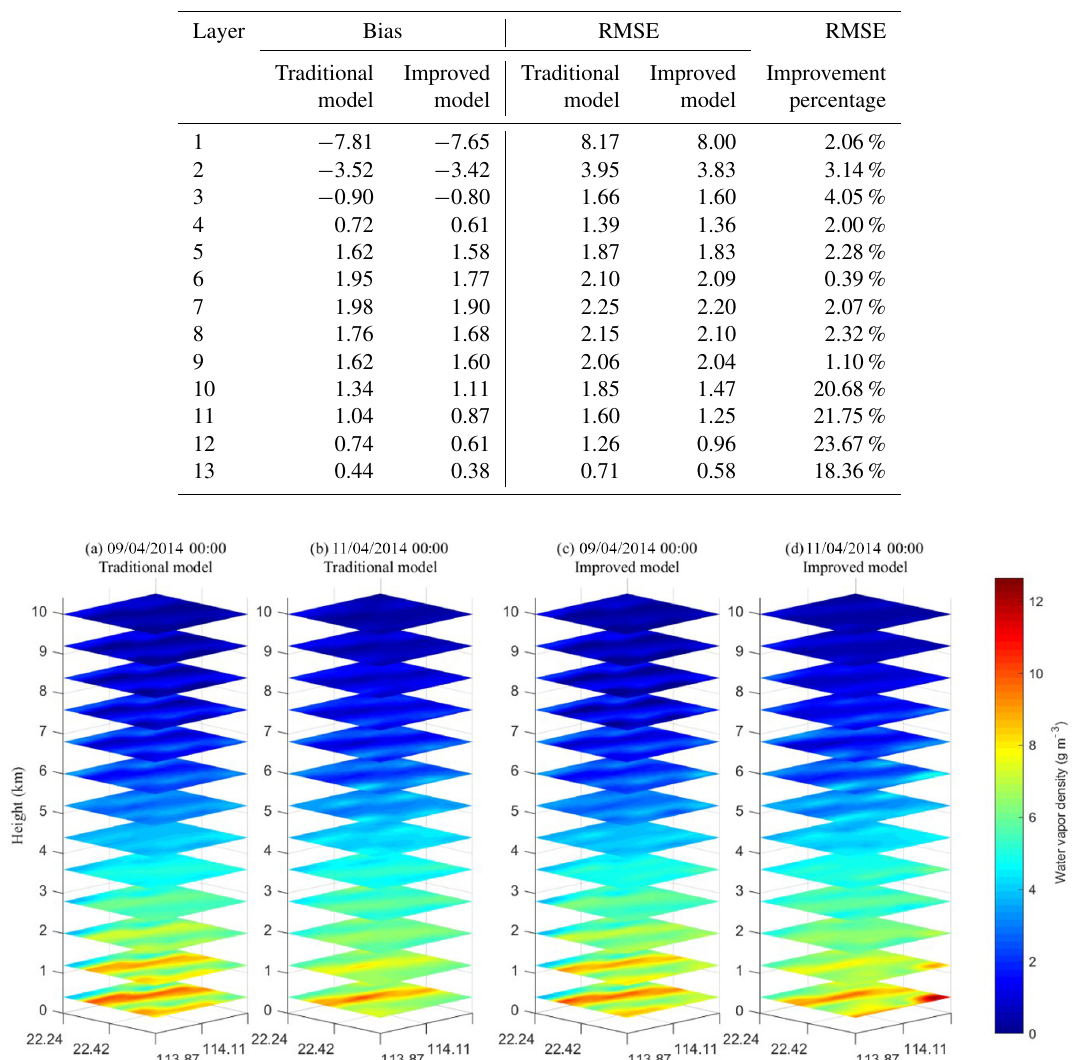
Table 2. Statistics of two models’ tomography accuracy with respect to ECMWF data in the spatial distribution scenario for the experimental period (unit: gm − 3 ).